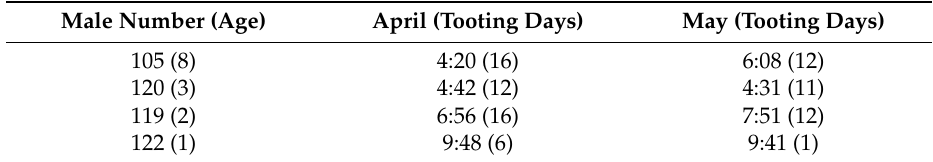
Figure 1. Correlation between Capercaillie males daily tooting duration and time females spent with the males in their sub-units in April and May. Table 3. Month and male age depending tooting latency in Capercaillie Breeding Center in Wisła Forestry